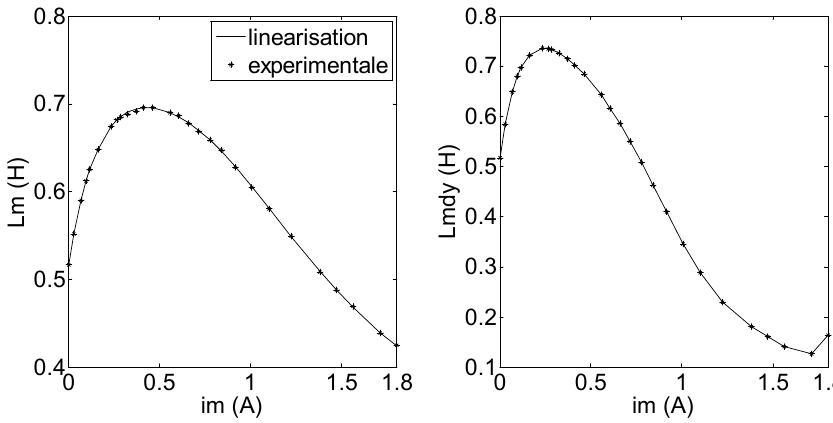
L mdy , according to the magnetizing current i m . The characteristic of the static magnetizing inductance is described by a polynomial of order 7, Equation (22).